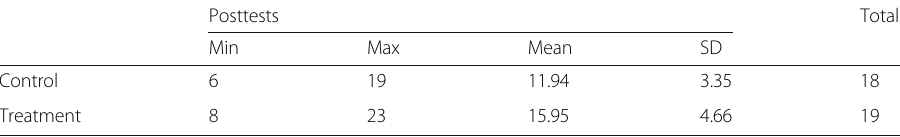
Table 1 Groups ’ Composition in terms of Reading Posttests Performance Posttests